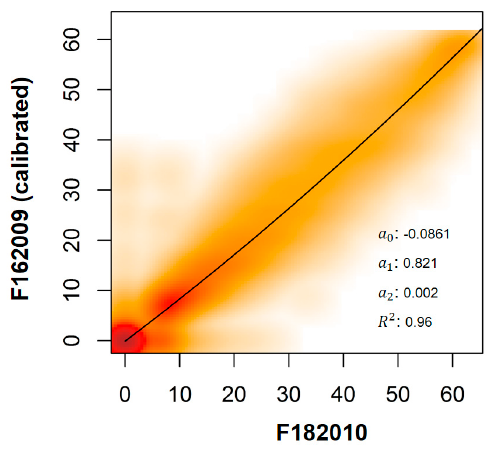
Figure 5 . Relationship (and coefficients) of NTL DNs between calibrated F162009 and F182010. Figure 5. Relationship (and coefficients) of NTL DNs between calibrated F162009 and